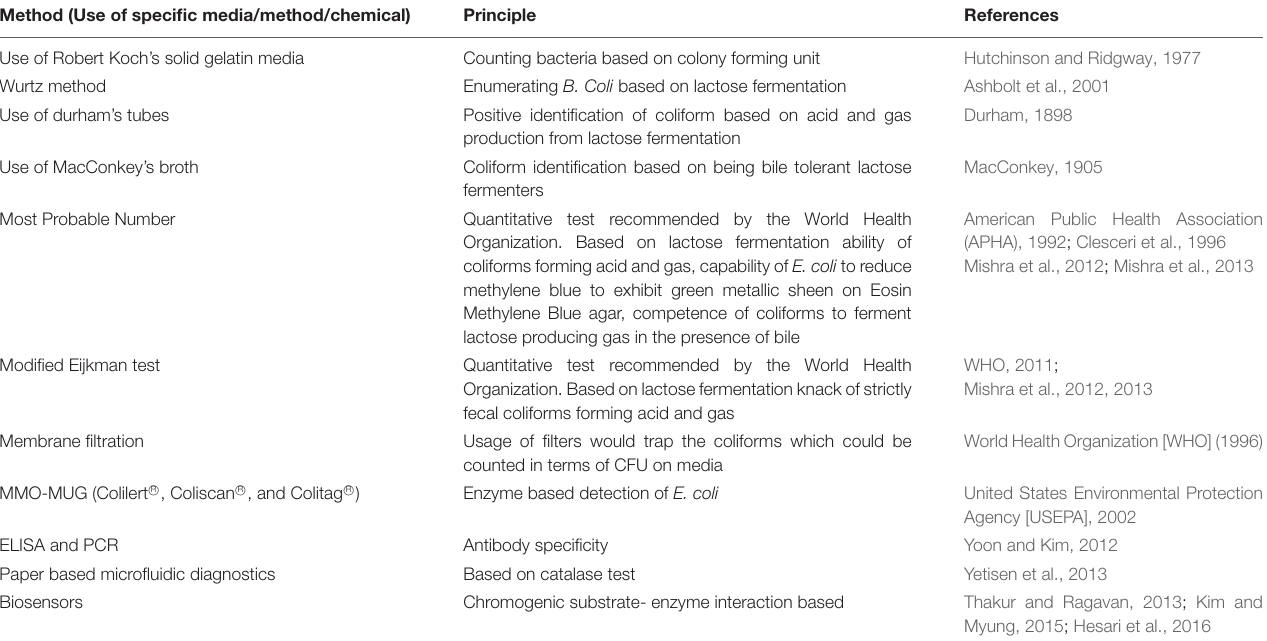
TABLE 1 | The various methods developed to detect the presence of coliforms. Method (Use of specific